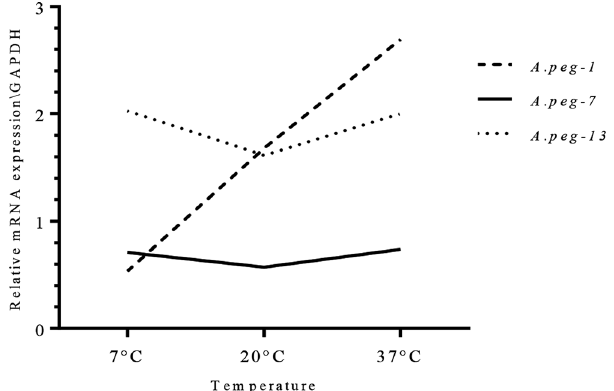
Figure 6. Trend of the relative expression of three selected genes coding for the ESPs proteins, A.peg-1, A.peg-7, A.peg-13 in response to temperature conditions, using the normalisation reference gene, gpd2